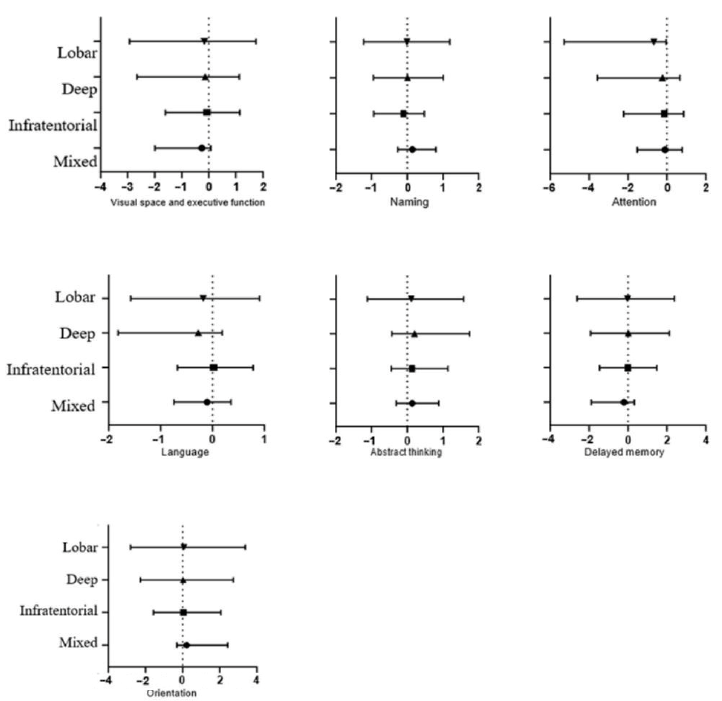
Figure 3. The relationship between CMBs in different regions and specific cognitive domains. Note: The x-axis represents the specific cognitive domains for the categories of lobar, deep, infratentorial, and mixed CMBs (y-axis), compared with a reference group without cerebral microbleeds. Error bars represent 95% confidence intervals.